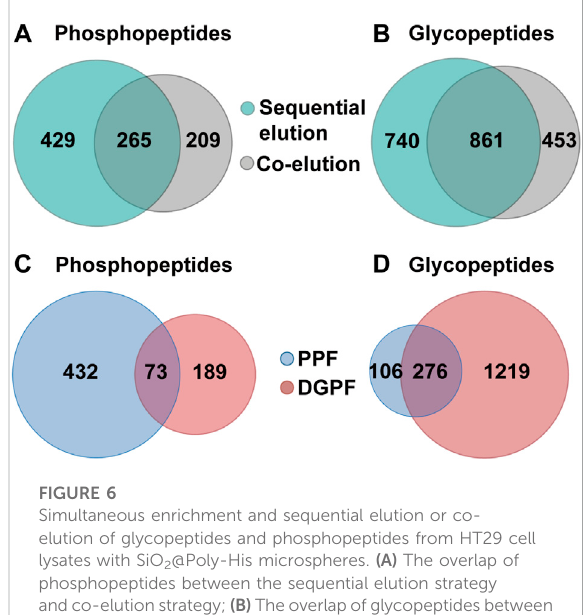
FIGURE 6 Simultaneous enrichment and sequential elution or co- elution of glycopeptides and phosphopeptides from HT29 cell lysates with SiO 2 @Poly-His microspheres. (A) The overlap of phosphopeptides between the sequential elution strategy andco-elutionstrategy; (B) Theoverlapofglycopeptides between the sequential elution strategy and co-elution strategy; (C) The overlap of phosphopeptides between deglycosylated peptide fraction and phosphopeptide fraction; (D) the overlap of glycopeptides between deglycosylated peptide fraction and phosphopeptide